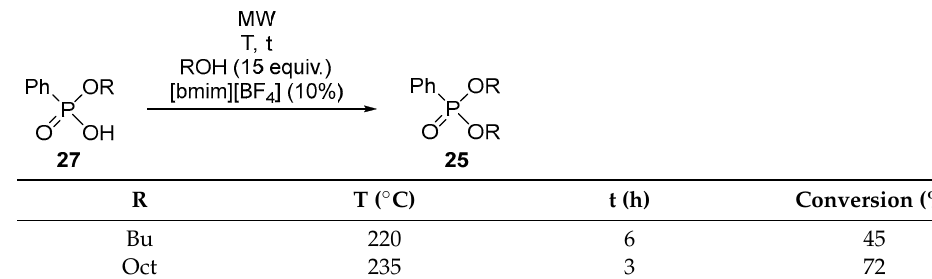
lating esterifications using BuBr. These reactions were complete and selective for the